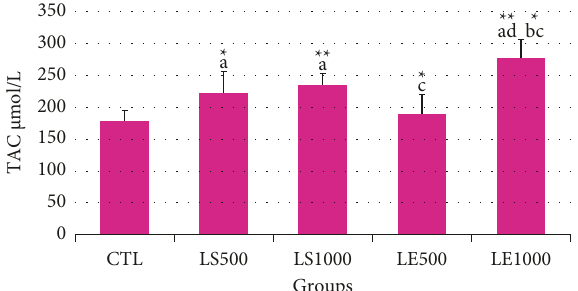
Figure 3: Effect of prenatal and postnatal exposure to flax hydroalcoholic extract or flaxseed on the total antioxidant capacity (TAC) level in the serum of female offspring mice. a A significant difference compared to the CTL group. b A significant difference compared to the LS500 group. c A significant difference compared to the LS1000 group. d A significant difference compared to the LE500 group. The values are represented as mean ± SEM. ∗ and ∗∗ indicate P < 0 . 05 and P < 0 . 01,